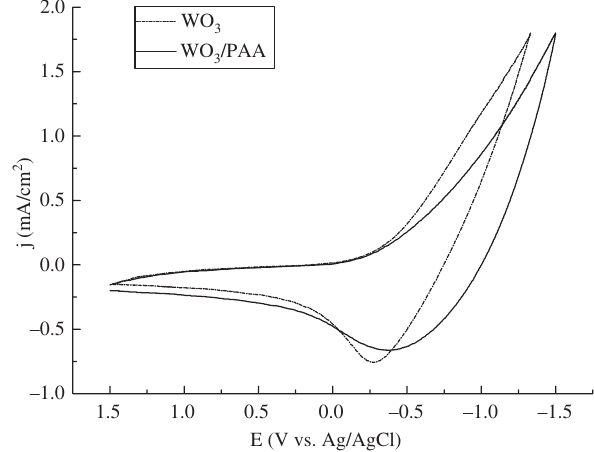
variation of 73 ~ 83% in the visible region. For the pure WO films, the bleached film also had a good transmittance property in the whole visible region, which was up to 80%.